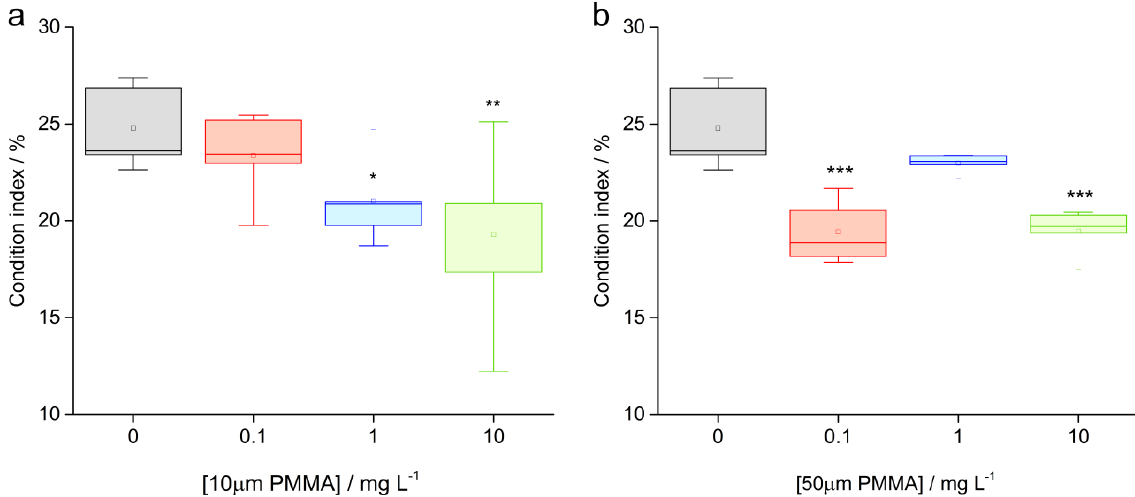
Figure 1. The CI of the control mussels (CON) and mussels exposed to 0.1 mg L − 1 (LOW), 1.0 mg L − 1 (MID) and 10 mg L − 1 (HIGH) PMMA microparticles of ( a ) 10 µ m diameter and ( b ) 50 µ m diameter. The boxes indicate the 2nd and 3rd quartiles, with the median value shown, and the whiskers denote the non-outlier ranges. The open circles indicate the outliers. Statistical significance is indicated at the levels * p < 0.05, ** p < 0.01, *** p <